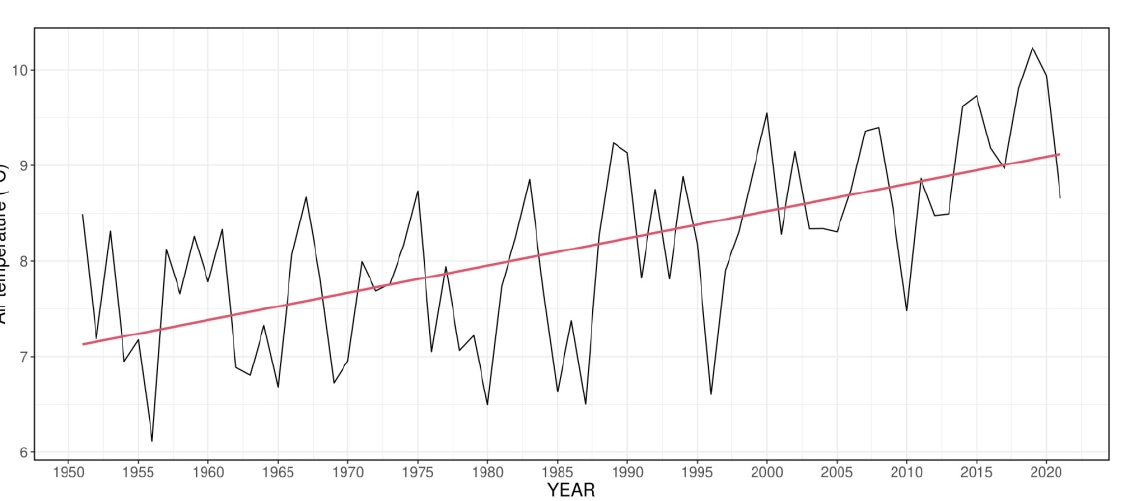
Figure 3. Course of area average annual air temperature in Poland (1951–2021).